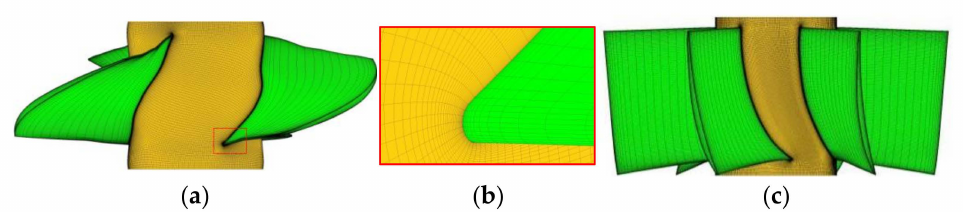
Figure 4. Figures of grids: ( a ) impeller; ( b ) grid refinement of impeller tip; ( c ) guide vane.